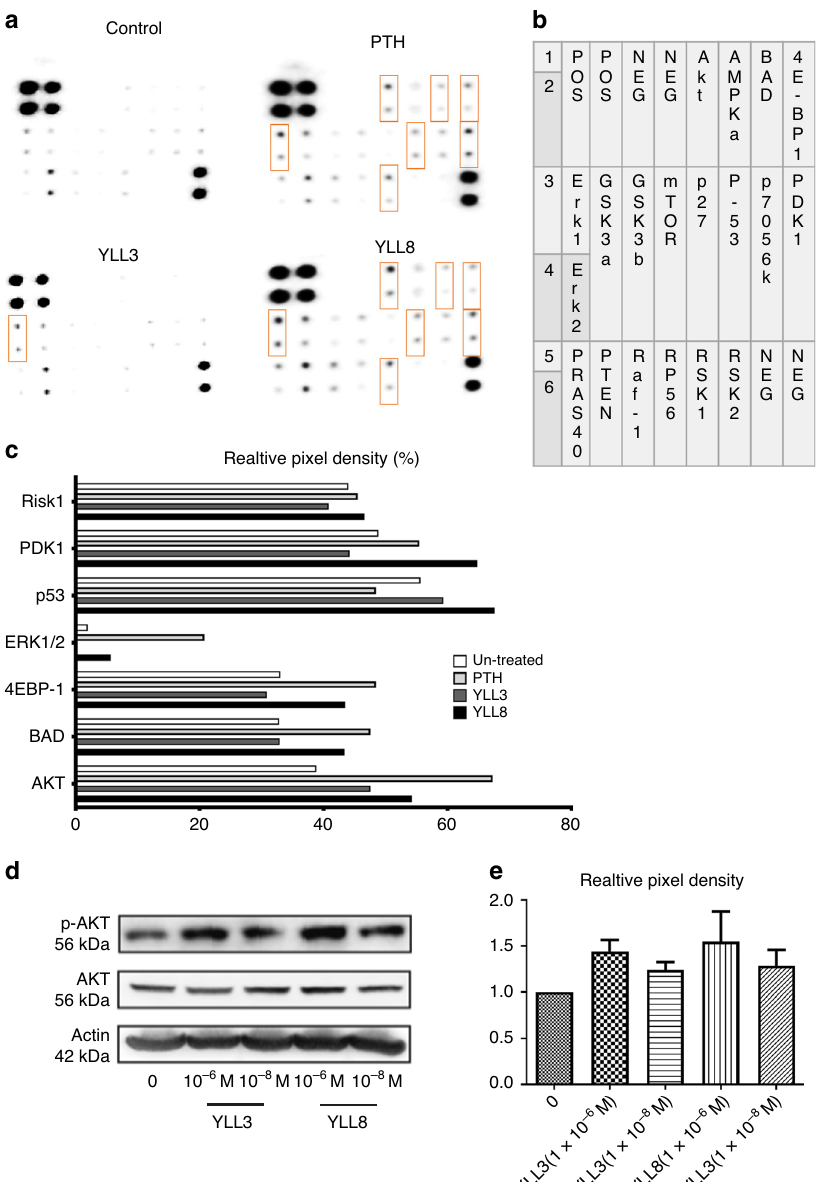
Fig. 3 YLLs activated the Akt signaling. a Mouse-derived MSCs were cultured with YLL3 or YLL8 peptides or hPTH (1 – 34) at 6 x 10 − 8 M in osteogenic medium for 2 h. The cell lysates were collected and used in an Akt protein array, measuring 18 phosphorylated proteins within the Akt signaling pathway. b The corresponding protein mapping of the Akt array listed in a . c Quantitative pixel density/blank control from selected dots highlighted in rectangles in b , which were differentially expressed compared to the control. d Human-derived MSCs were cultured with YLL3 or YLL8 at indicated concentration in osteogenic media for 2 h. Cell lysates were collected for western blotting of p-Akt, Akt, and beta-actin. Representative gel images from each treatment and e quantitative pixel density for p-Akt measured from n = 3 independent experiments/group presented in “ d ”